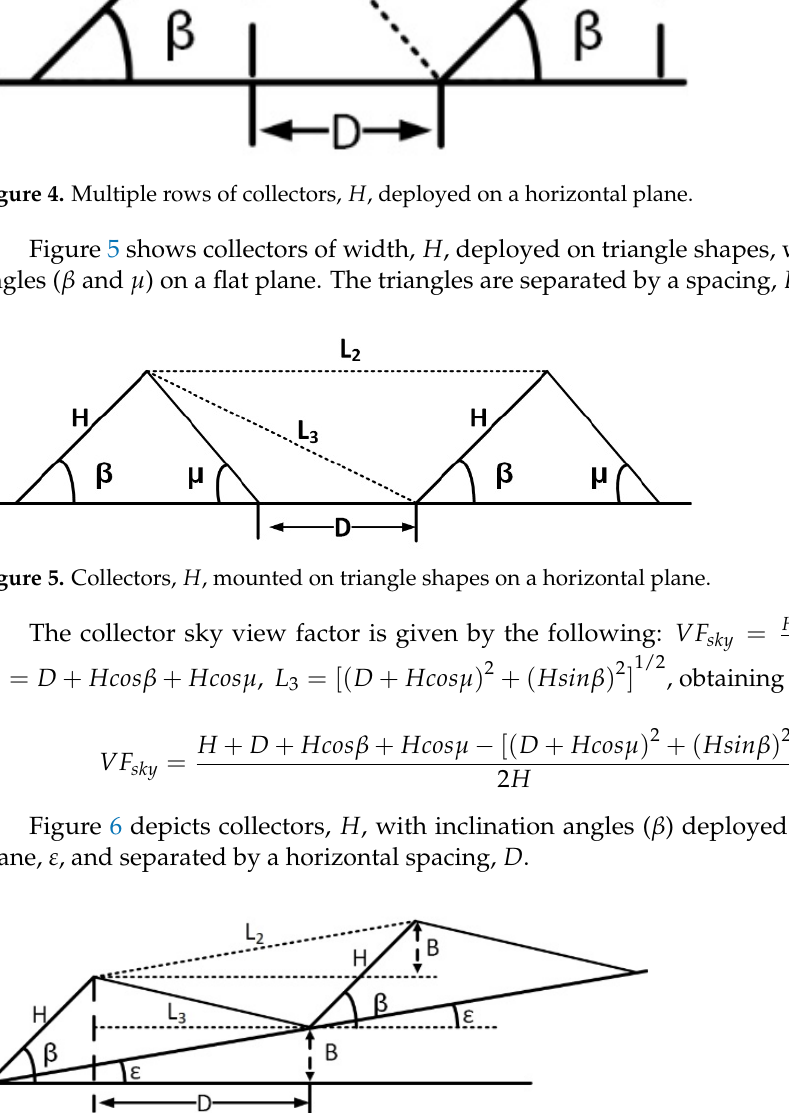
Figure 6. Collector, 𝐻 , deployed on an inclined plane, 𝜀